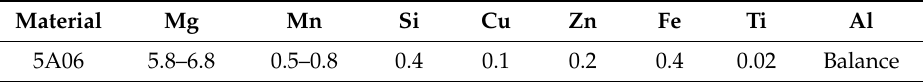
Table 1. Chemical composition of the 5A06 aluminum alloy (wt